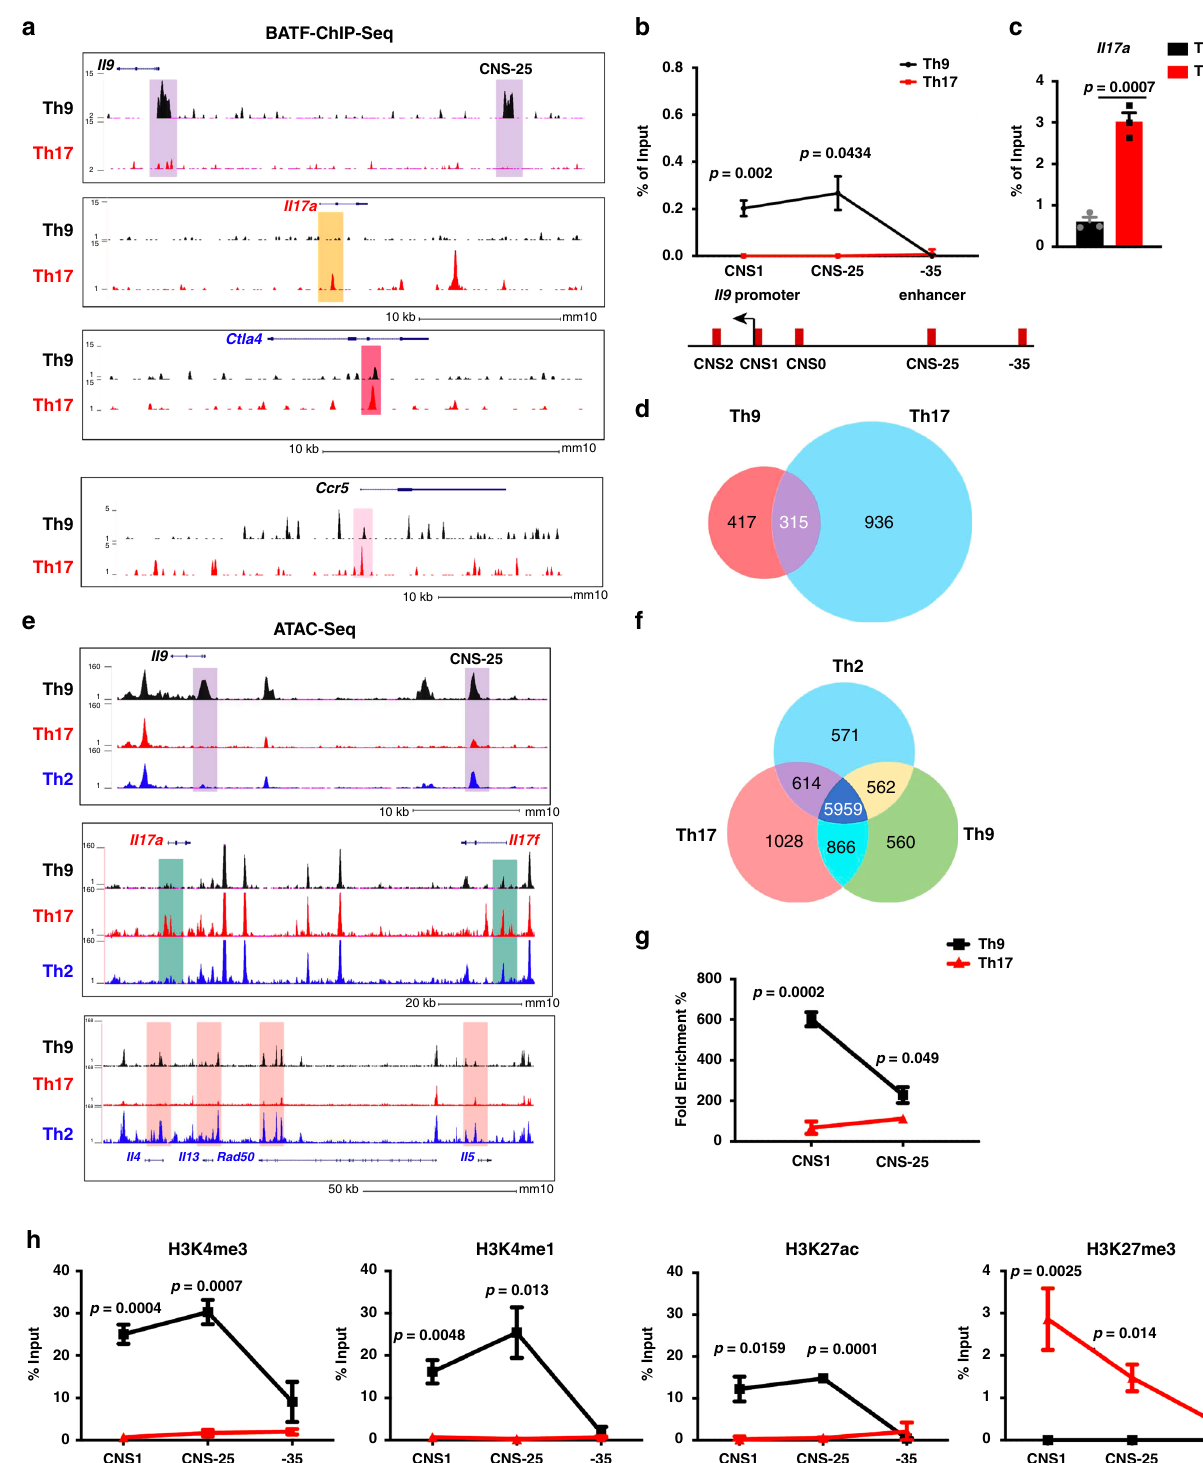
Fig. 1 Lineage-speci fi c BATF binding and chromatin structure at the Il9 gene. Naive CD4 + T cells were isolated from the spleen and differentiated into Th9 and Th17 cells for 5 days. ChIP assay and chromatin accessibility assay were performed on day 5. a BATF ChIP-seq-binding peaks in Th9 and Th17 cells on day 5 culture. b ChIP-qPCR analysis of BATF binding at the Il9 gene locus (top) on day 5 culture and diagram of the Il9 gene locus (bottom). c ChIP- qPCR analysis of BATF binding at the Il17 gene locus on day 5 culture. d Venn diagram indicating the overlap of BATF-binding peaks between Th9 and Th17 cells. e Genome browser view of ATAC-seq peaks in day 5 cultured Th9, Th17, and Th2 cells at the Il9 , Il17a-Il17f , and Il4-Il13 - Rad50 - Il5 gene loci. f Venn diagram indicating the overlap of ATAC-seq peaks in promoter regions in Th9, Th17, and Th2 cells. g Chromatin accessibility analysis of Il9 gene locus in Th9 and Th17 cells on day 5 culture. h ChIP-qPCR analysis of the binding of H3K4me1, H3K4me3, H3K27ac, and H3K27me3 on Il9 locus on day 5 culture. b , c , g , h Data are the mean ± SEM of three mice per experiment and representative of two independent experiments. An unpaired two-tailed Student ’ s t -test was used for generating p -values. See also Supplementary Fig.